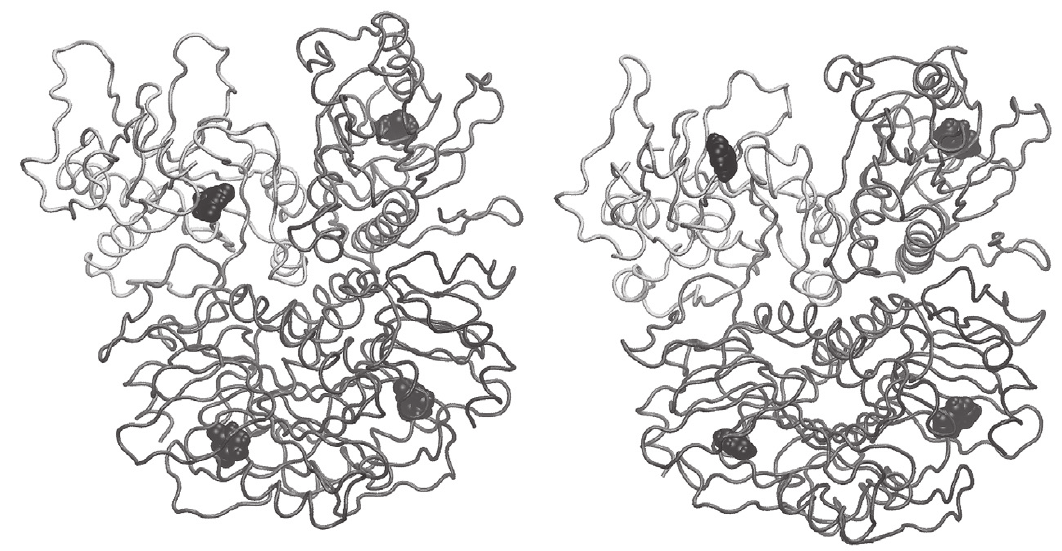
Figure 4 - Structures of the complexes PPTM-dihydrouracil (right side) and PPTM-9 H -purine (left side), in which the protein is represented by Tube format and ligands are represented by the VDW format. This image was created by VMD 1.9.1